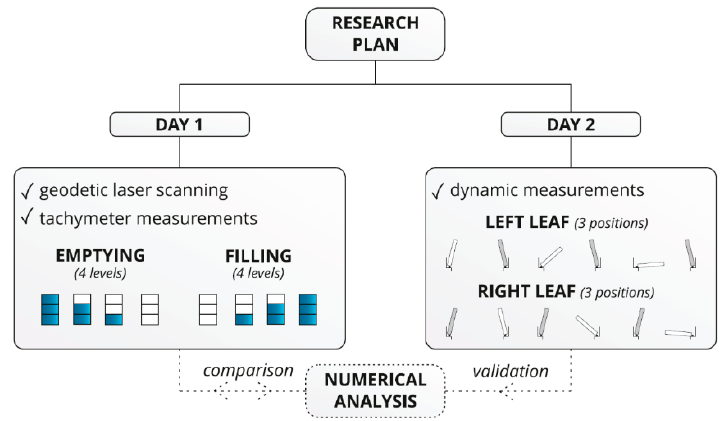
Figure 4. Diagram of tests regarding the lock in the Wloclawek river Figure 4 . Diagram of tests regarding the lock in the Wloclawek river barrage. Figure 4 . Diagram of tests regarding the lock in the Wloclawek river barrage.